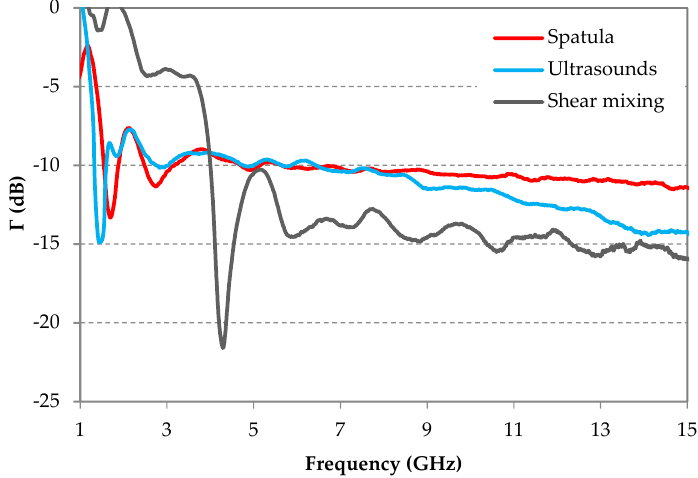
Figure 5. The frequency dependence of the measured reflection coefficients of epoxy foams loaded with 0.5 wt.% of 3 mm-CFs and prepared with the three methods of process: spatula, ultrasounds, and shear mixing.